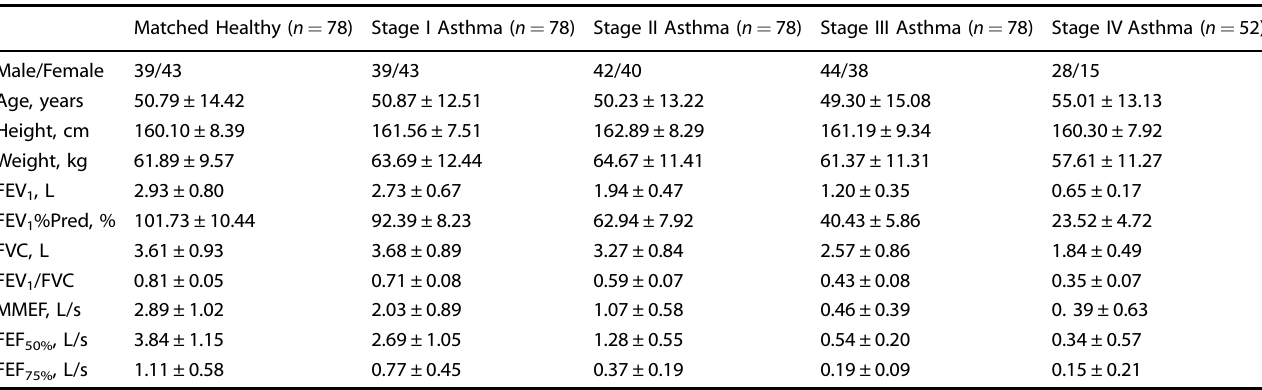
Table 3. Demographic characteristics and spirometric parameters (mean ± standard deviation) of asthmatic patients and matched healthy